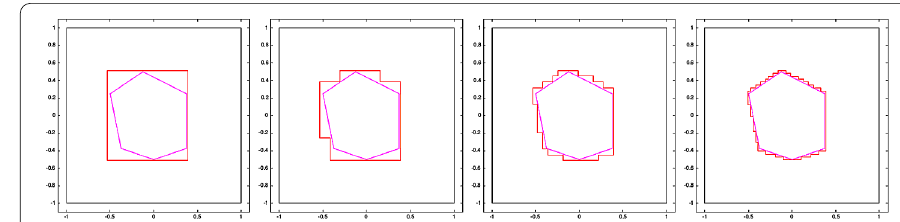
and (cid:9) ex . h h . The interior h